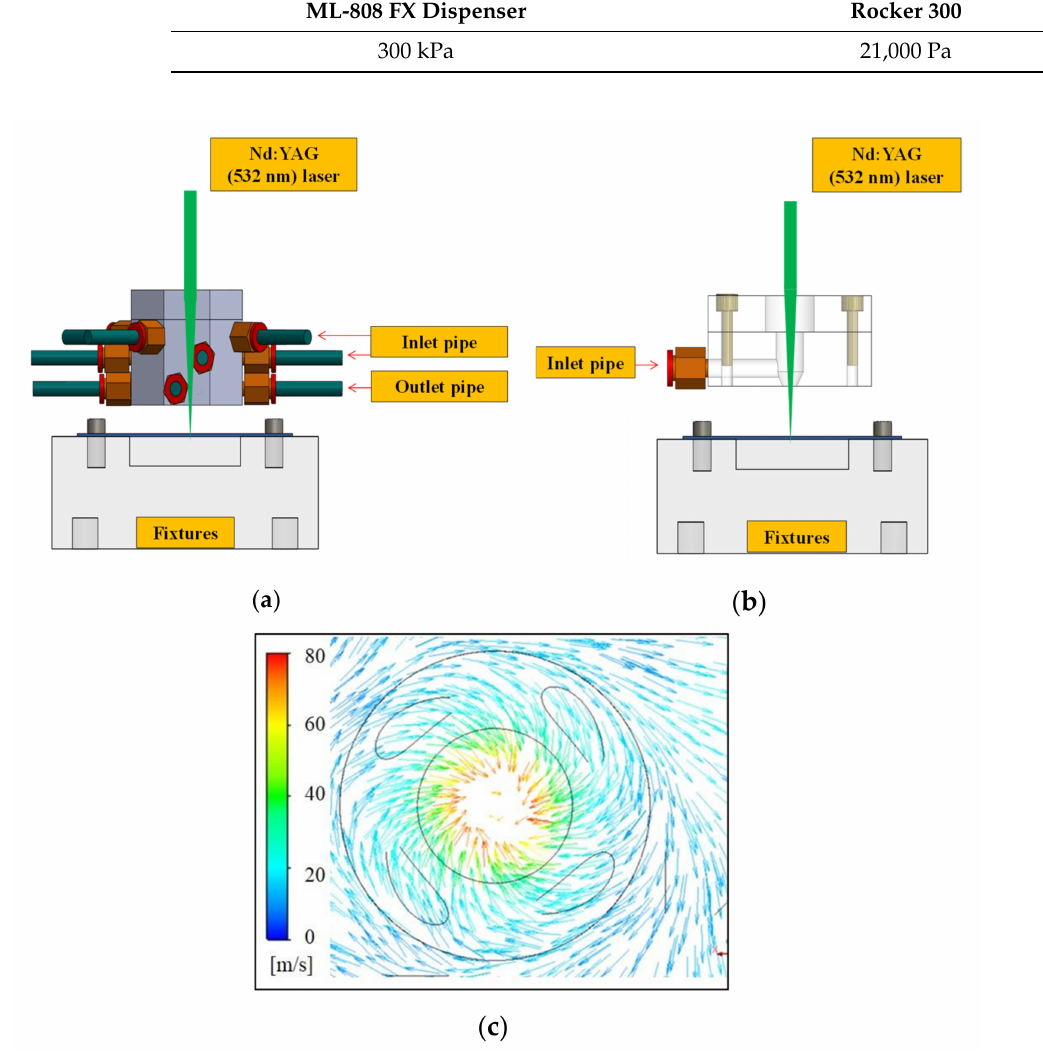
Figure 3. Schematic diagram of two gas-assisted mechanisms: ( a ) vortex jet assist mechanism; ( b ) direct injection auxiliary mechanism; ( c ) flow line distribution on the surface of the test